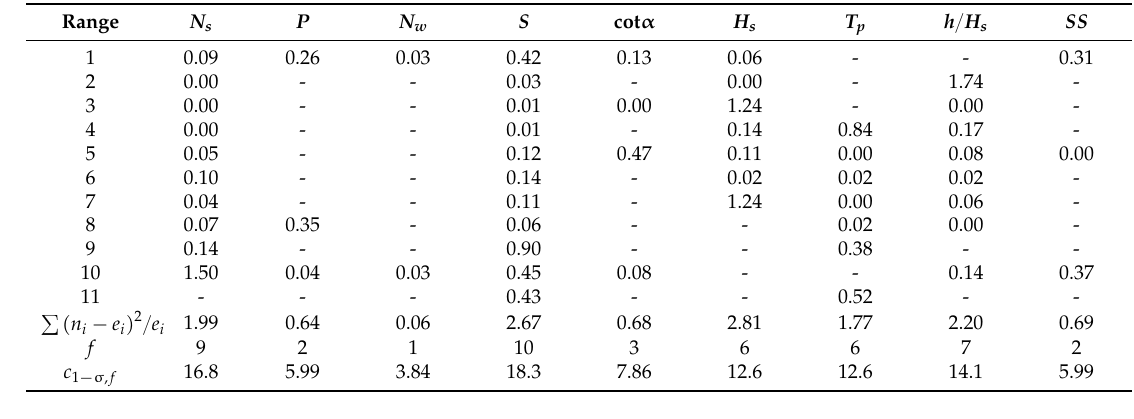
Table 3. Residual chart of chi-square tests.